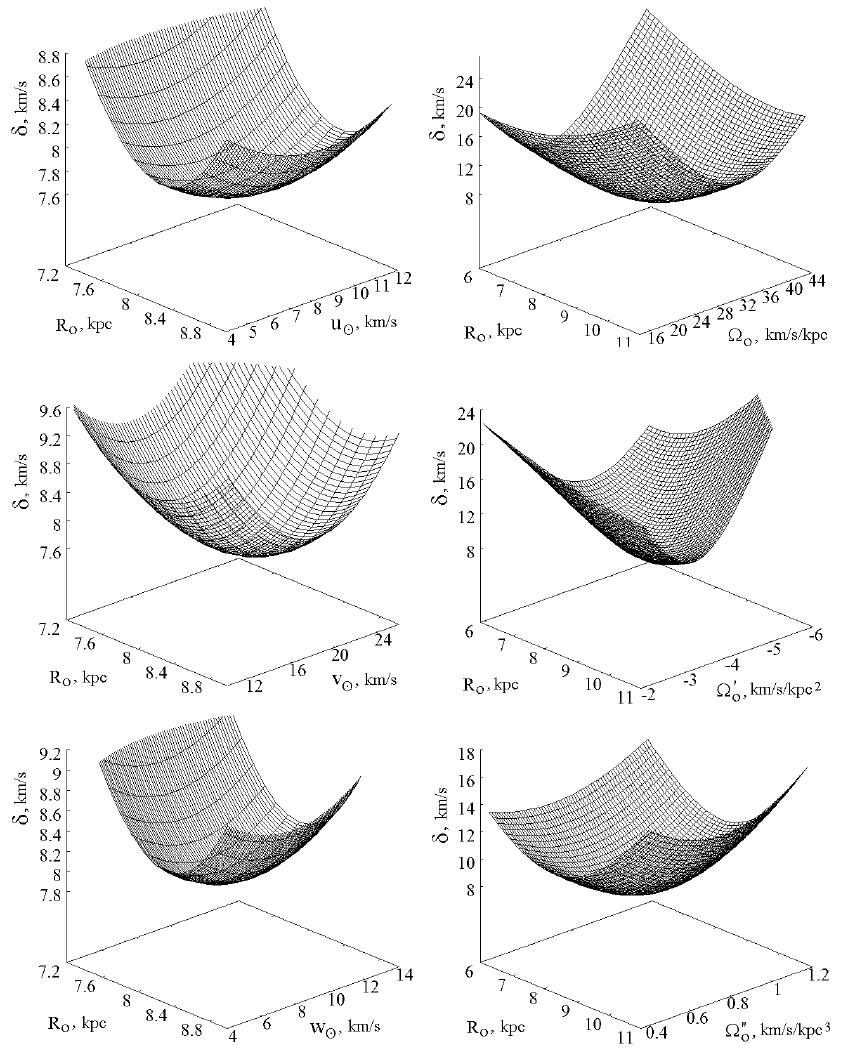
Fig. 1. Graphical representation of the dependence of the square root of residual p functional (cid:14) = F on two parameters: (1) R 0 and (2) u ⊙ ; v ⊙ ; w ⊙ ; Ω 0 ; Ω ′ the remaining parameters fixed at the values corresponding to solution